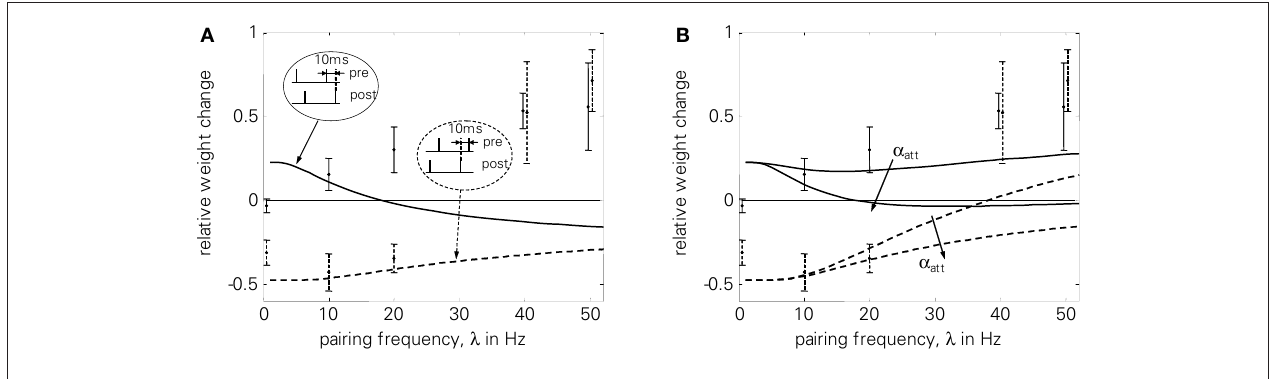
standard STDP [the upper curve (pre-post pairings) is also shown qualitatively in Standage et al. (2007)], (B) LCP with SRM neuron for α Sjöström parameter set as listed in Table 4. Normalized error without attenuation: E = 6.8.